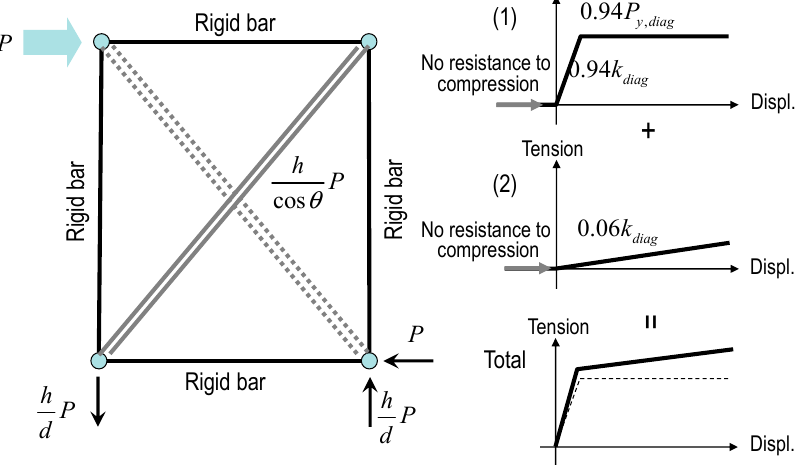
Figure 12. Diagonal truss modeling using two parallel elements.